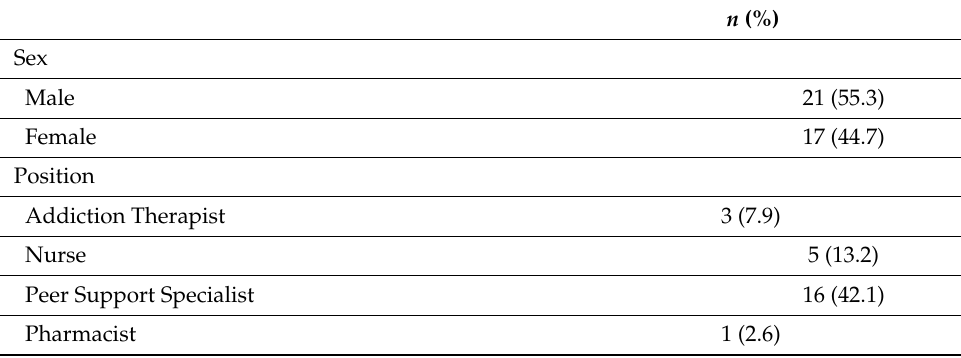
Table 1. Study sample characteristics ( n =